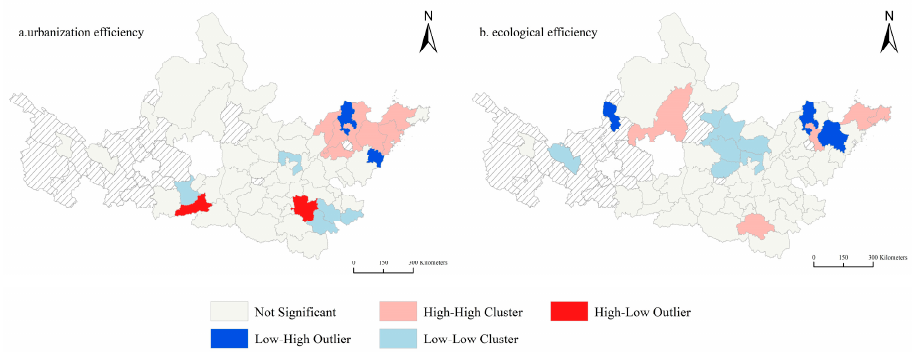
Figure 6. LISA agglomeration map of urbanization efficiency and ecological efficiency in the Yellow River basin, China.